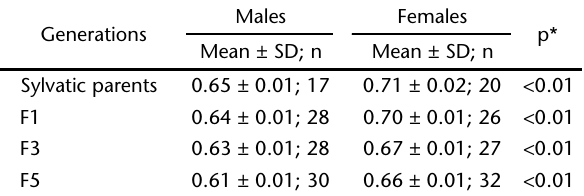
Table I. Comparison of wing centroid size differences between males and females of Rhodnius neglectus populations (sylvatic parents and their generations). * Post-hoc Tukey tests, (SD) standard deviation, (n) number of